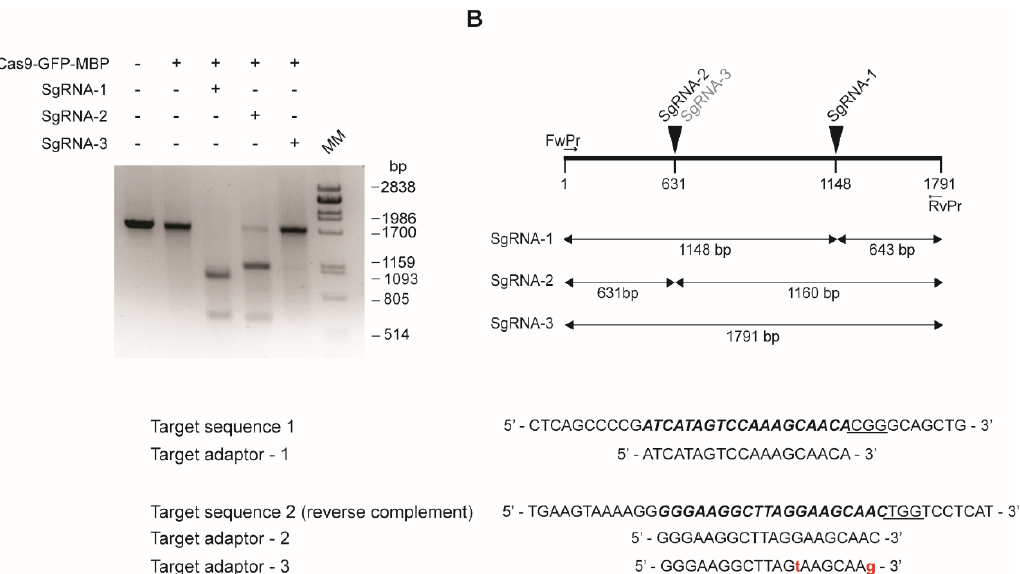
Figure 4. In vitro cleavage assay. ( A ) Separation of cleaved DNA fragments by electrophoresis in 1% agarose gel. A 1791 bp DNA fragment corresponding to Glyma.06G072000 gene was PCR amplified from soybean genomic DNA using FwPr and RvPr primers. Two specific sgRNAs (sgRNA-1